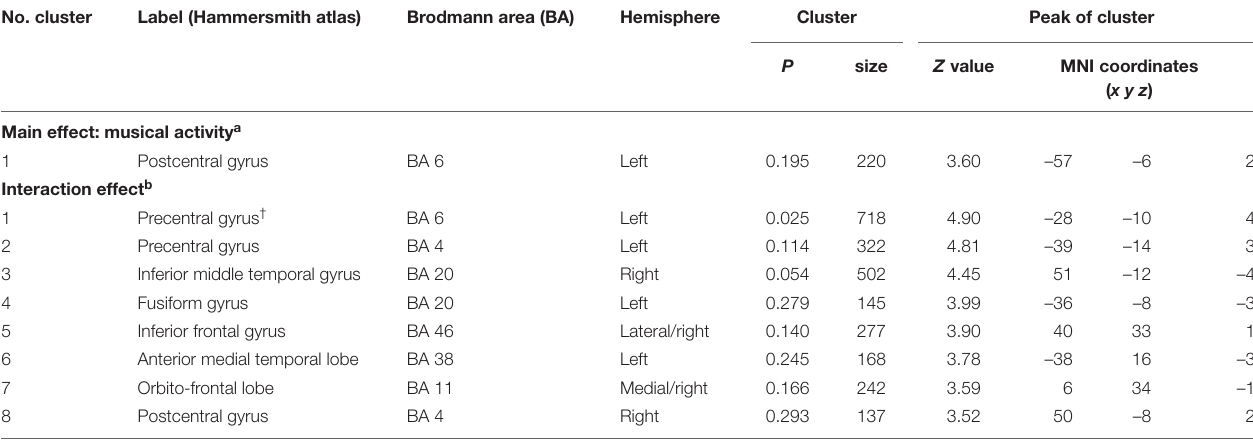
TABLE 5 | Results of analyses between musical activity and GMV at the voxel level. No. cluster Label (Hammersmith